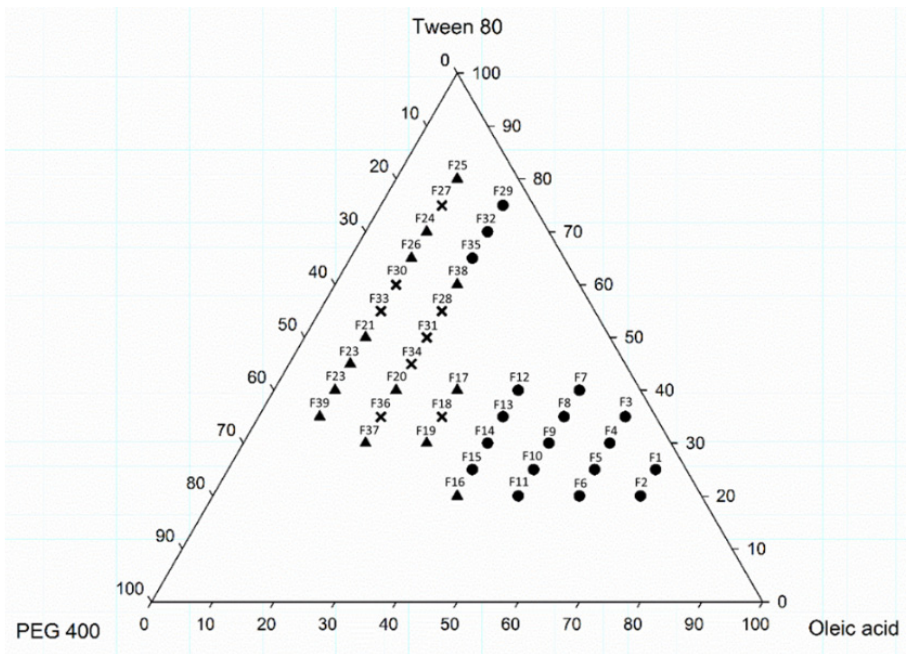
Figure 1. Ternary phase diagram of CLT-loaded OA-SMEDDS containing oleic acid (OA), Tween 80 (TW80), and polyethylene 400 (PEG 400). ● : Transparent appearance. ▲: Precipitation occurred. × : Both precipitation and a turbid appearance were exhibited. All samples were visually observed after 15 days of storage at ambient temperature.